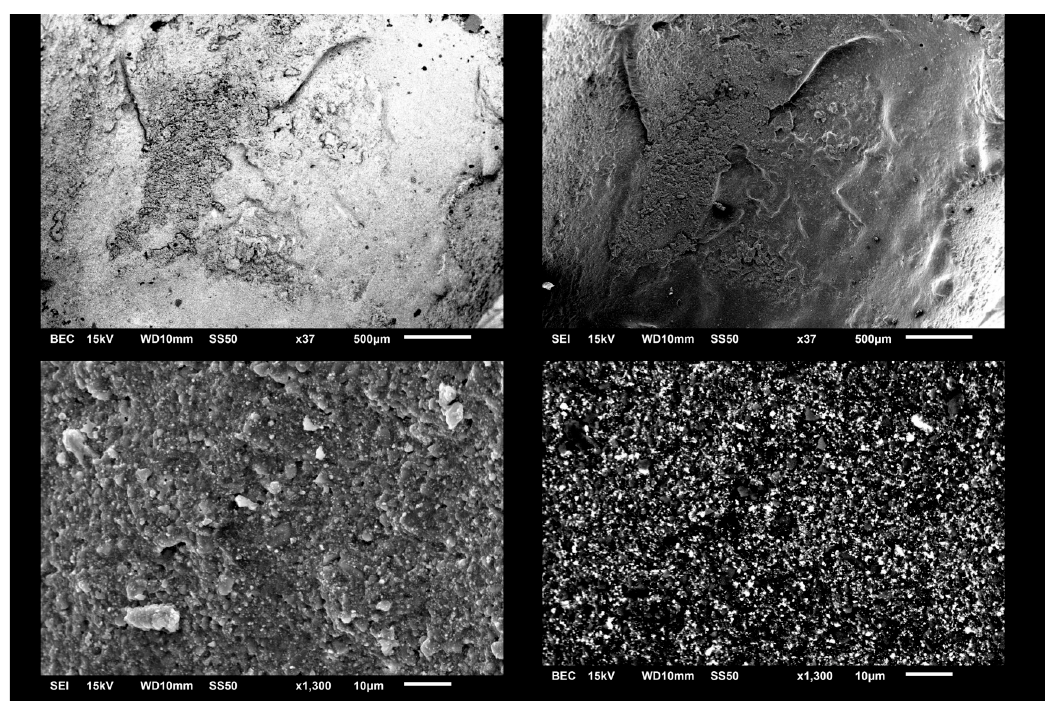
Fig 3. SEM Images of lithium disilicate crown after irradiation at 500 μ m and 10 μ m scale, note intact surface with residual cement. Top left and right demonstrates undamage smooth lithium disilicate material with some residual cement 500 μ m scale. Bottom left and right demonstrates normal crystal structure of lithium disilicate at 10 μ